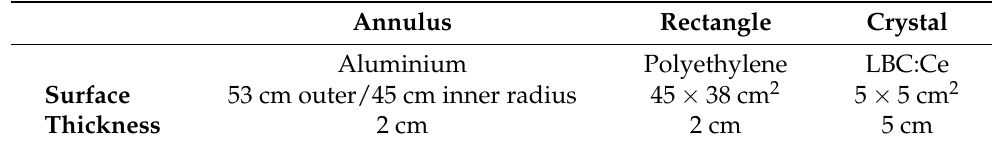
Table 2. Material and dimensions of the specimen and of the scintillator.